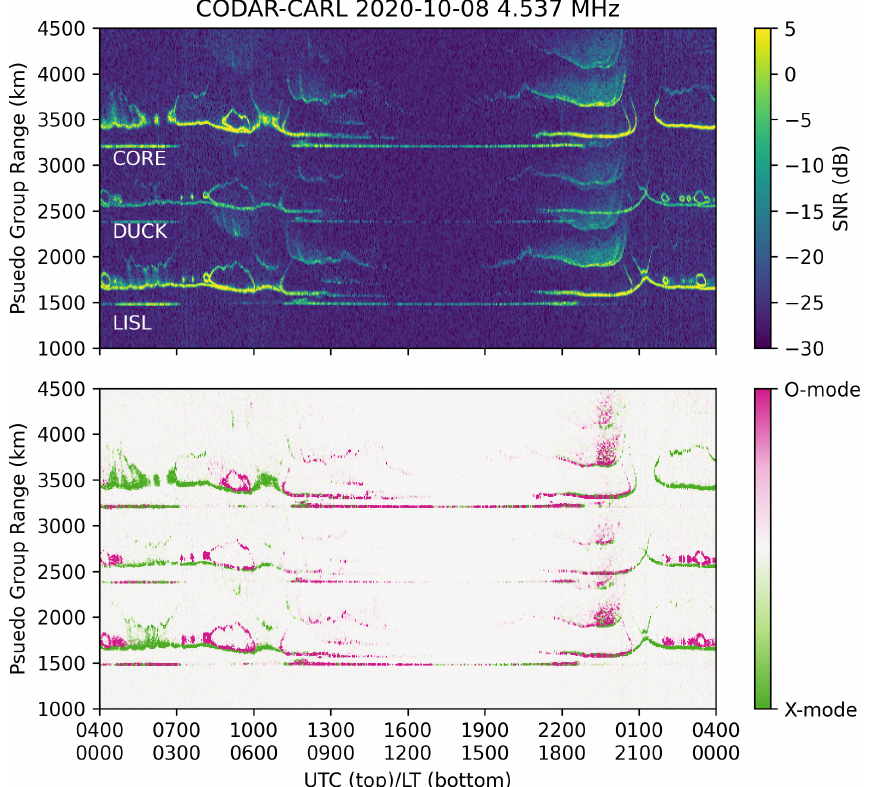
Figure 3. Top row: 24h (pseudo) range–time–intensity plot from three North Carolina CODAR transmitters received at CARL at 4.53718MHz on 8 October 2020. Bottom row: polarization separation of O- and X-mode propagation as purple and green, respectively. See the text for further